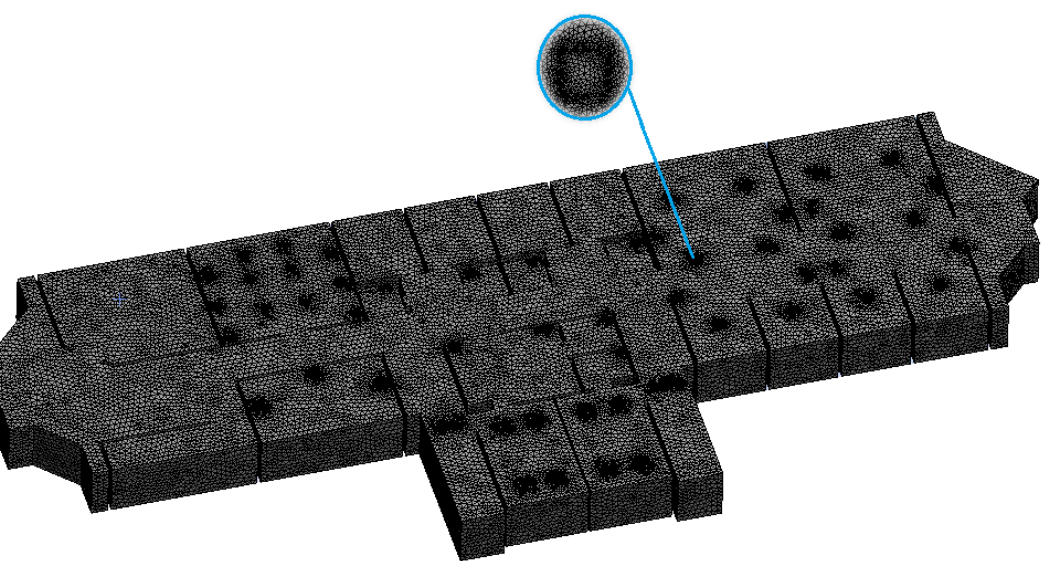
Figure 2. CFX mesh of the model.